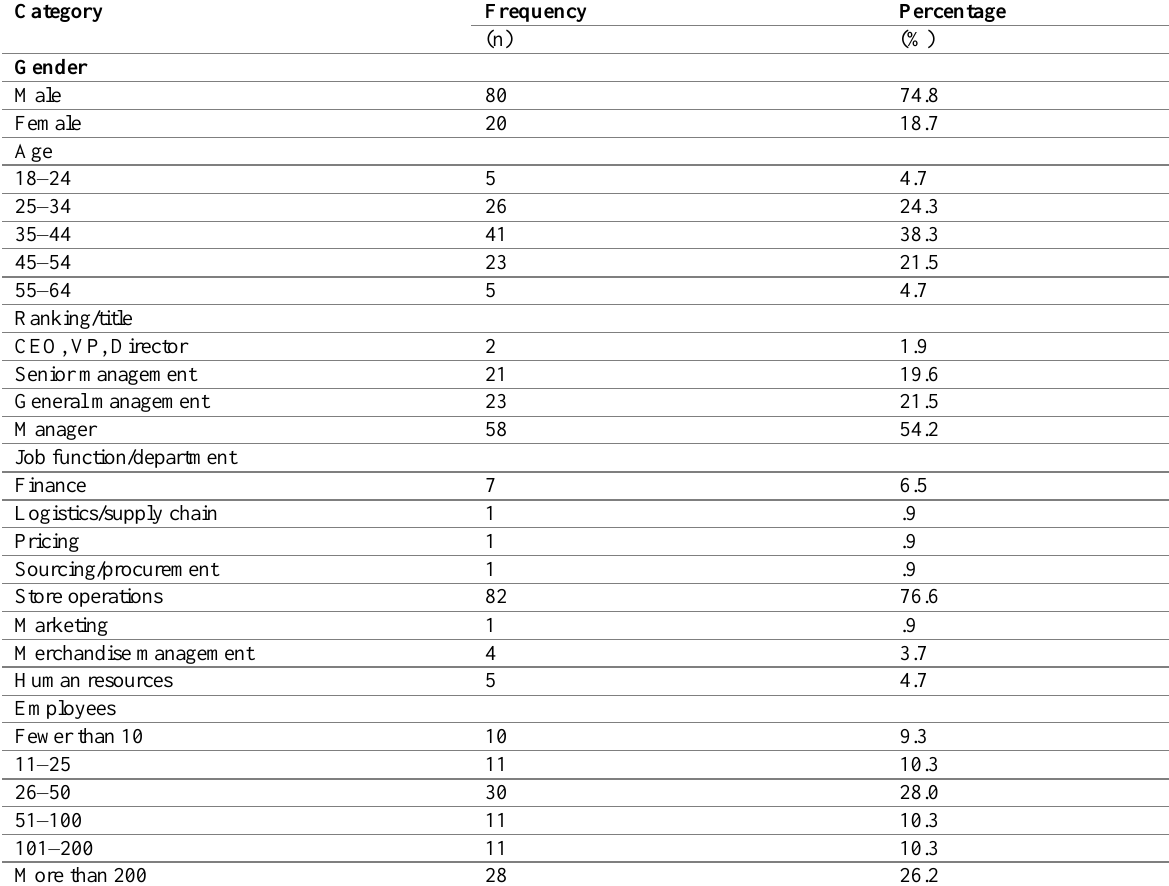
Table 3: Summary: Respondent Statistics